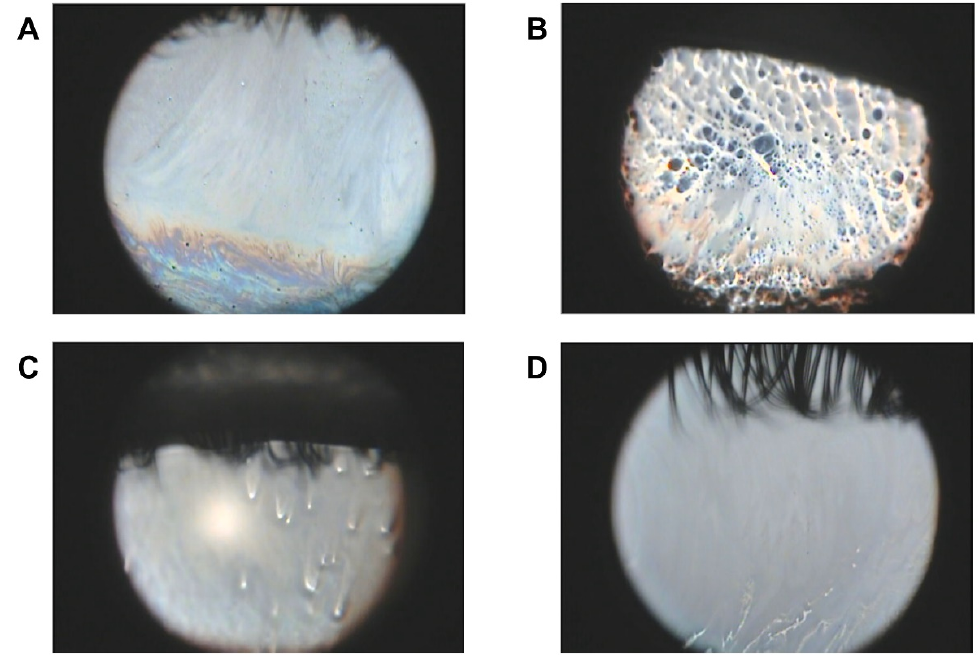
Figure 3. Four patterns of tear film break-up have been observed. ( A ) normal interference color images without break-up; ( B ) area break-up; ( C ) spot break-up; ( D ) line